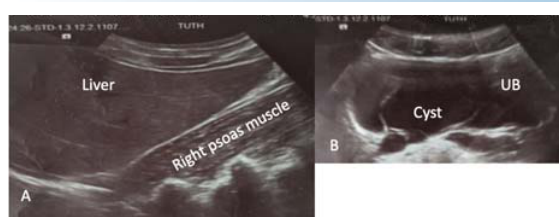
Figure 3. Transrectal sonography (TRUS) images showing dilated right ejaculatory duct communicating with dilated right seminal vesicle protruding into the urinary bladder (A); Rather than purely anechoic, there are innumerable punctate echogenic dots/ low level internal echoes seen within the cyst (B).